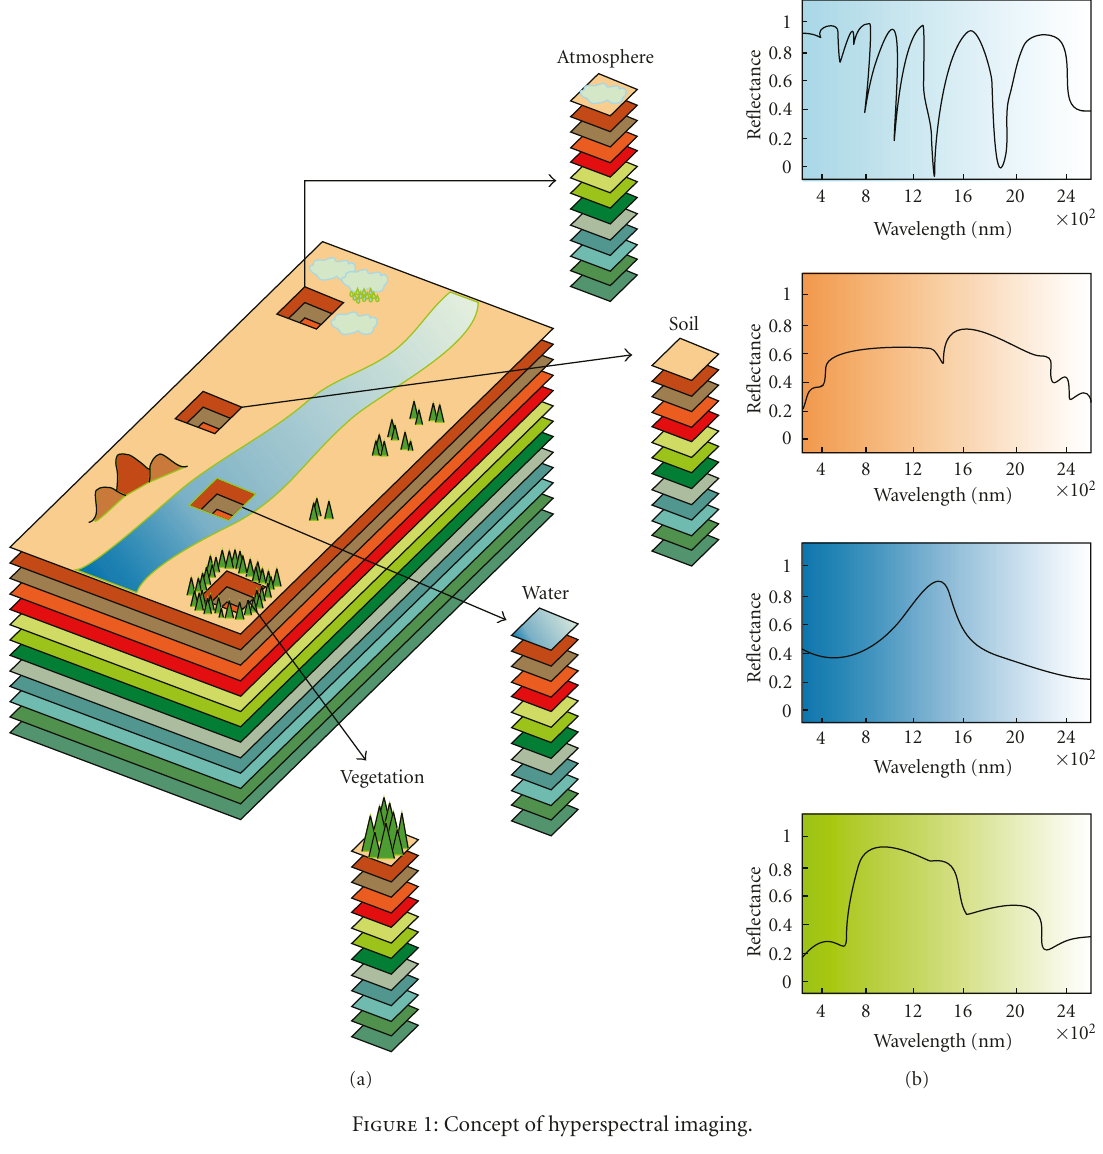
Figure 1: Concept of hyperspectral imaging.